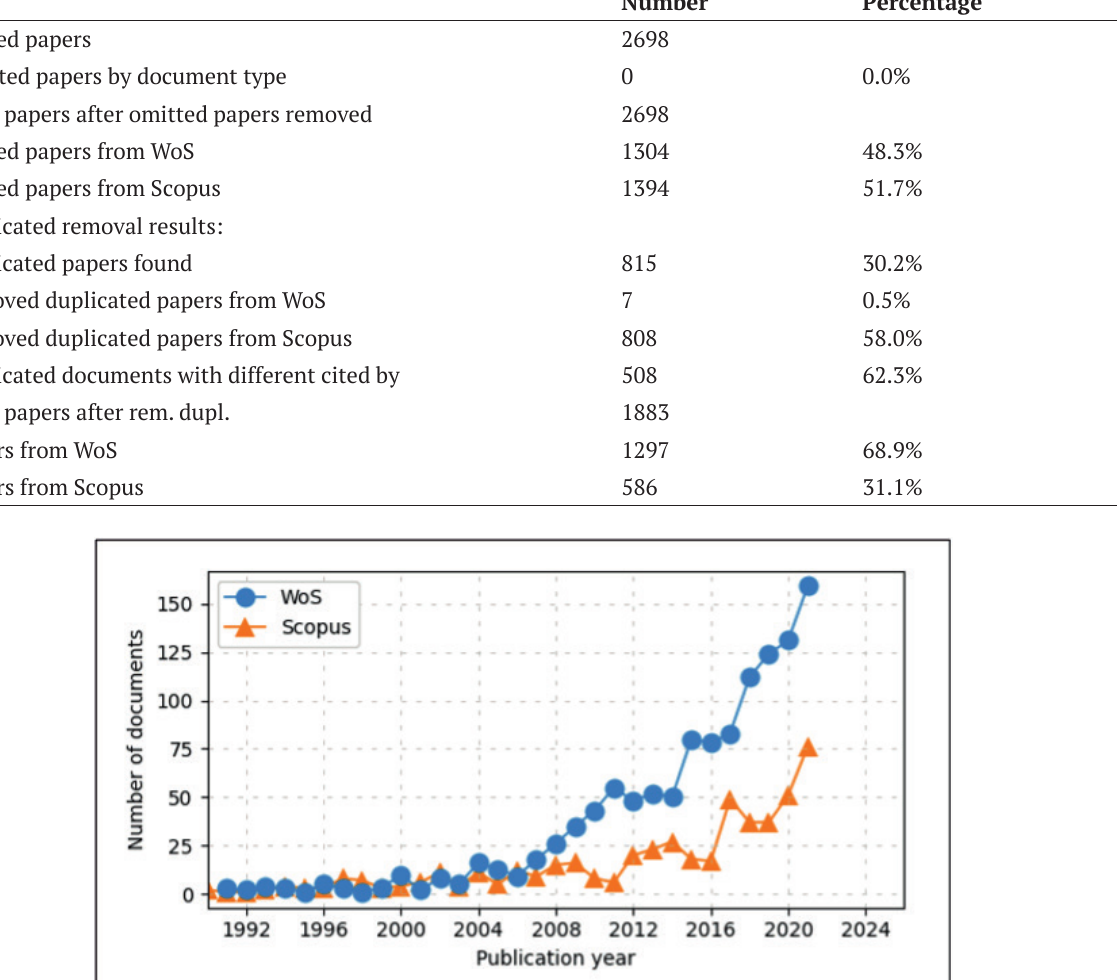
Figure 1. The publication growth of harassment and bullying in sport on Scopus and WoS databases Source: (Results of ScientoPy software analysis up to August 23,